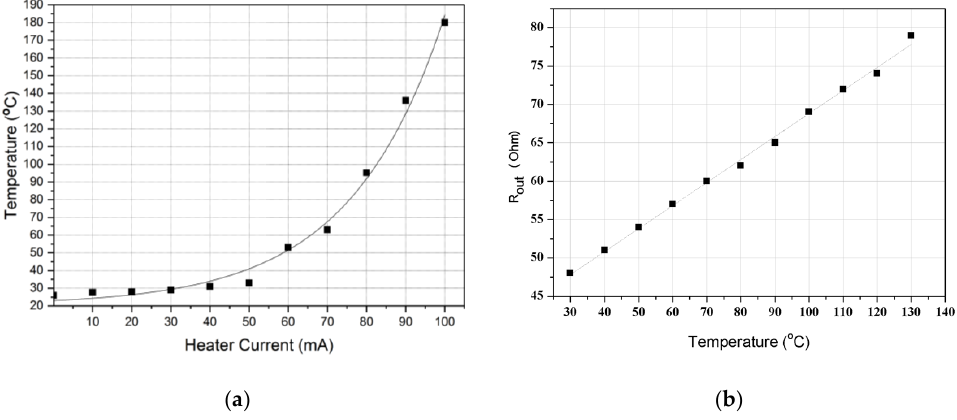
Figure 4. ( a ) Current – temperature characteristics of the micro heater and ( b ) temperature-resistance characteristics of the micro temperature sensor.